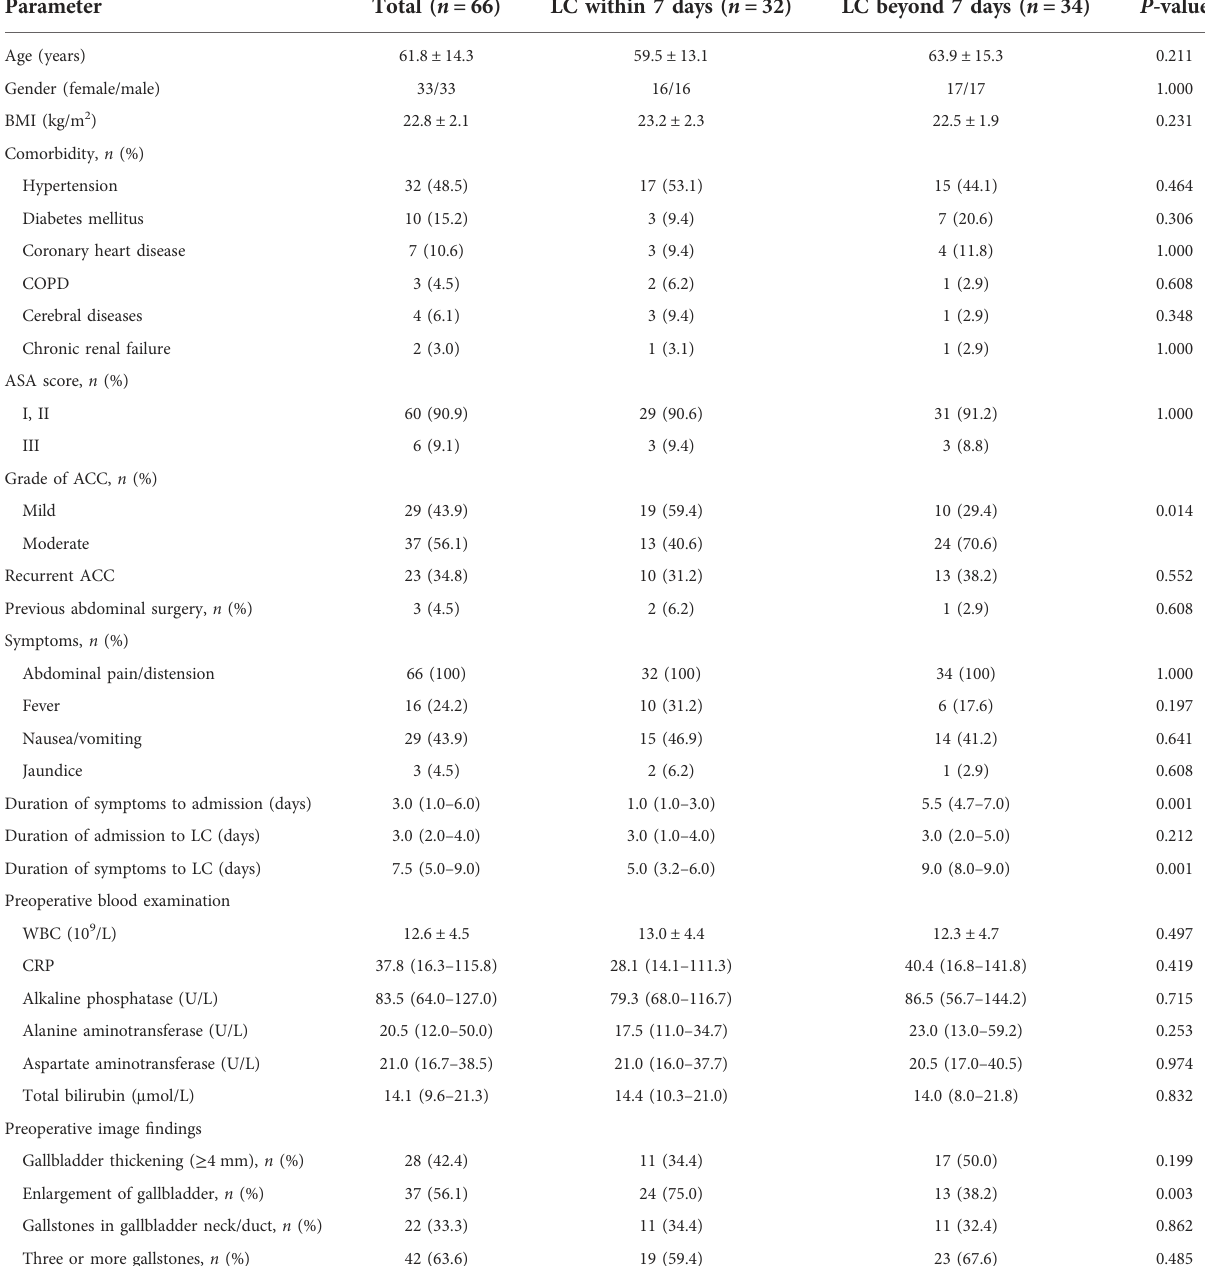
TABLE 1 Demographic and preoperative data of patients included in the